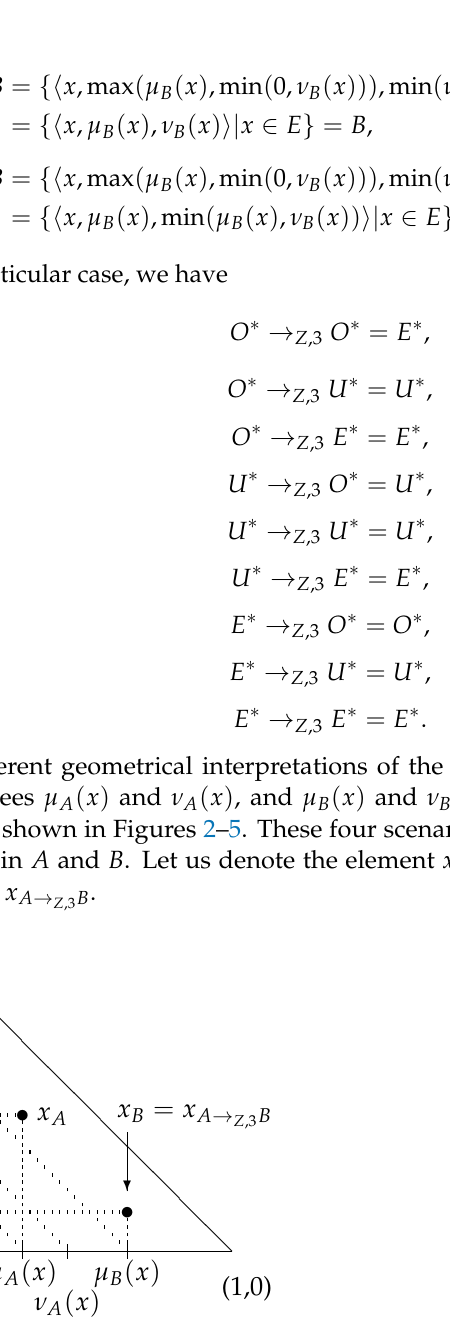
Fig. 2: Geometrical interpretations of elements x A , x B and x A